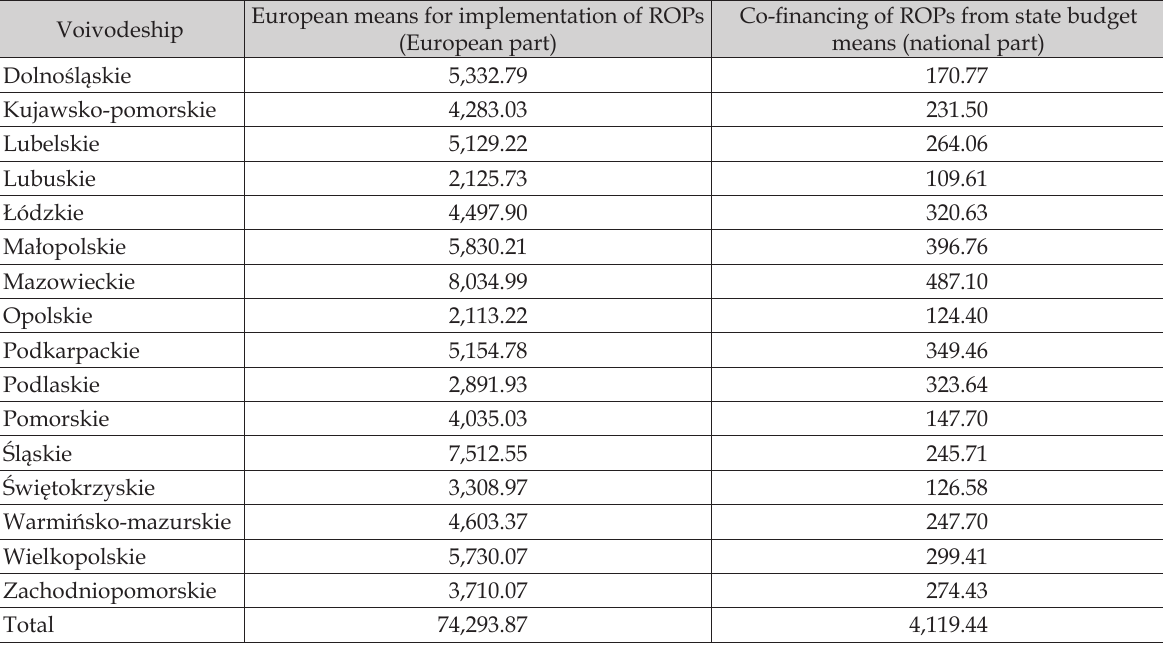
Table 3. Means spent in province contracts in the period 2007–2013 (in million